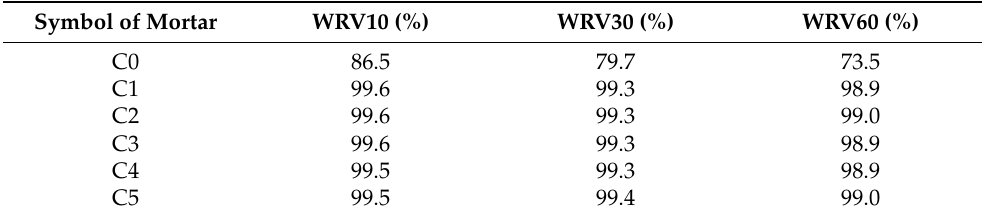
Table 5. Water retention results.